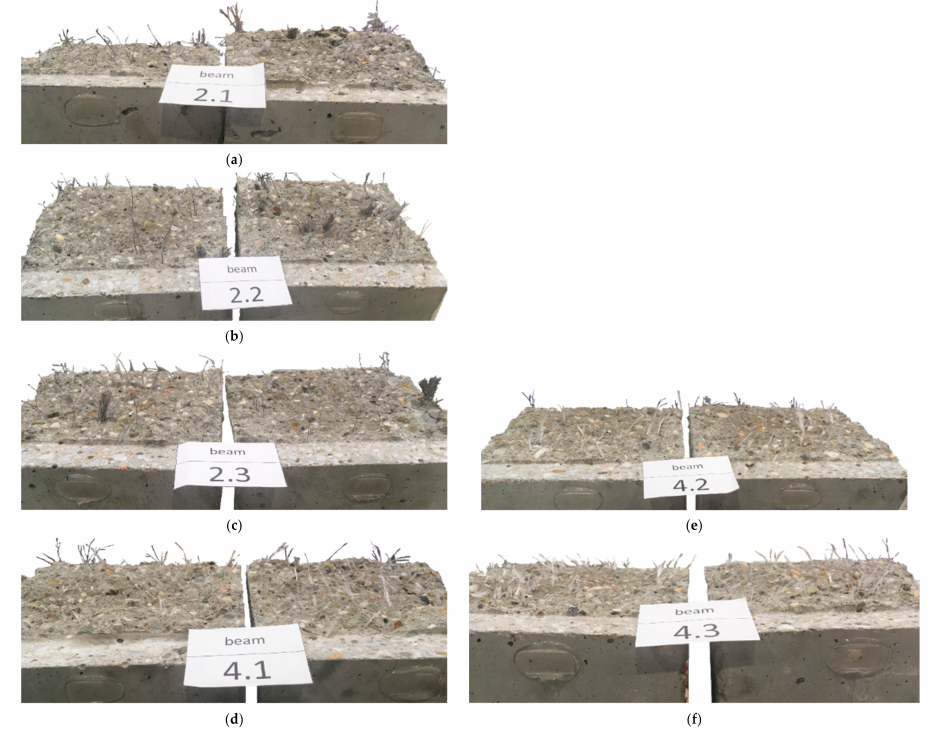
Figure 17. FRC beams broken in the crack cross-section: ( a ) PM_3_1; ( b ) PM_3_2; ( c ) PM_3_3; ( d ) PD_3_1; ( e ) PD_3_2; ( f )